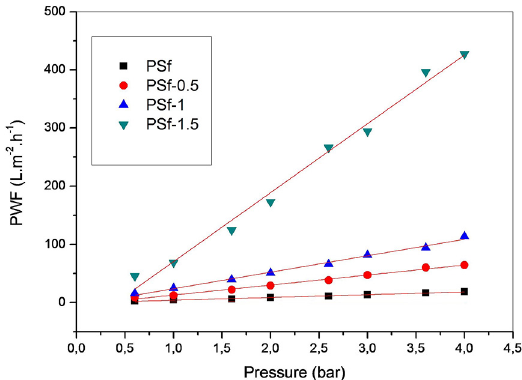
Figure 10: Effect of MC dosage on the pure water flux at different trans-membrane pressure (20°C, ΔP 0.6-4 bar).